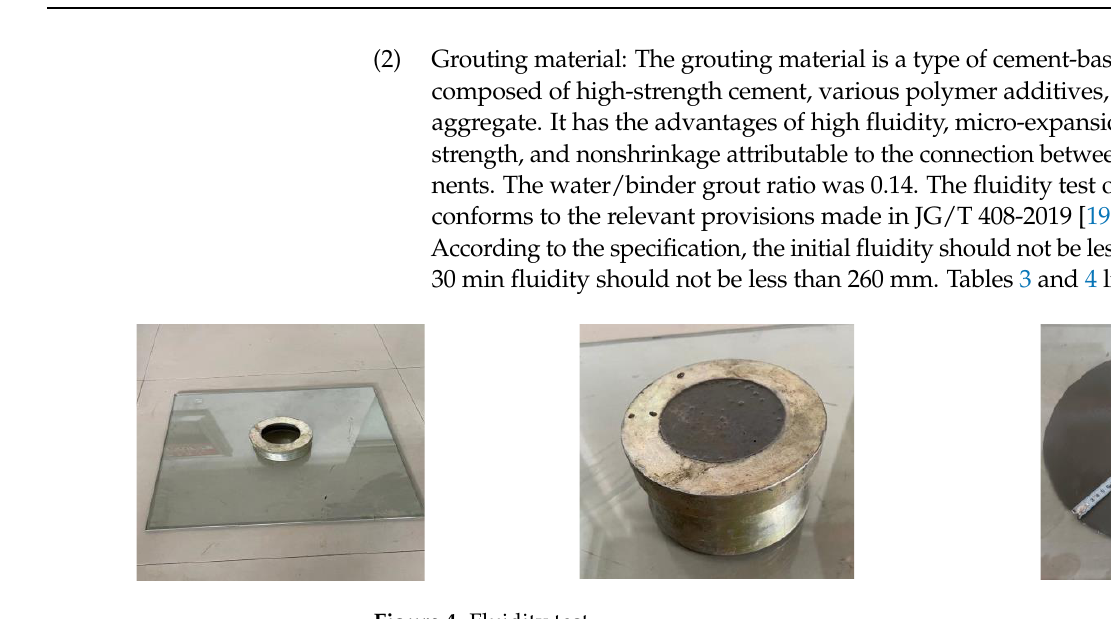
Figure 4. Fluidity test. Table 3. Fluidity of initial grouting material (unit: mm).